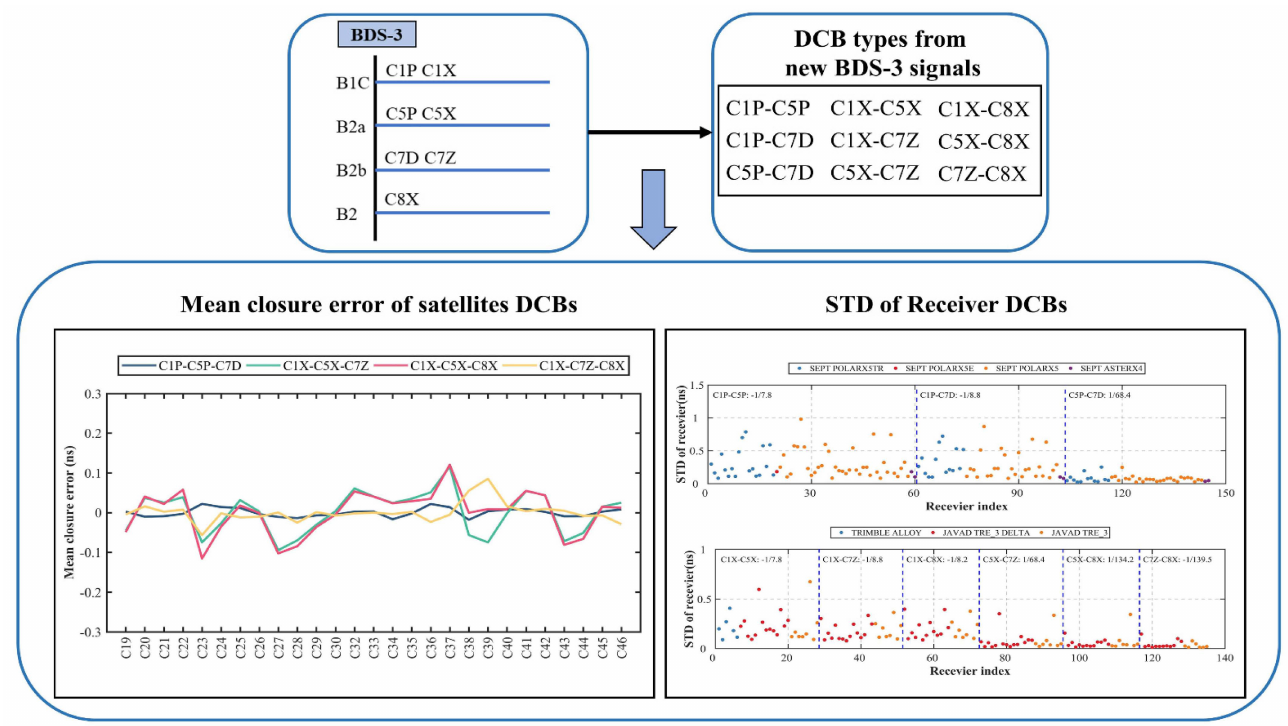
Figure 7. Mean closure error of BDS-3 satellites DCBs and STD of recilver DCBs